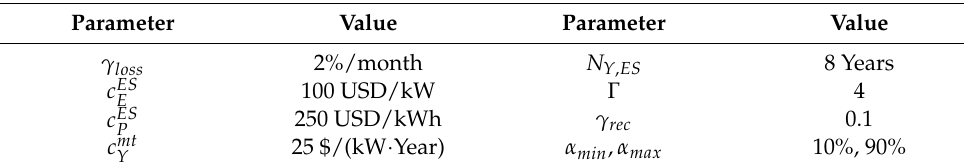
Figure 2. The modified IEEE 24-bus power system.